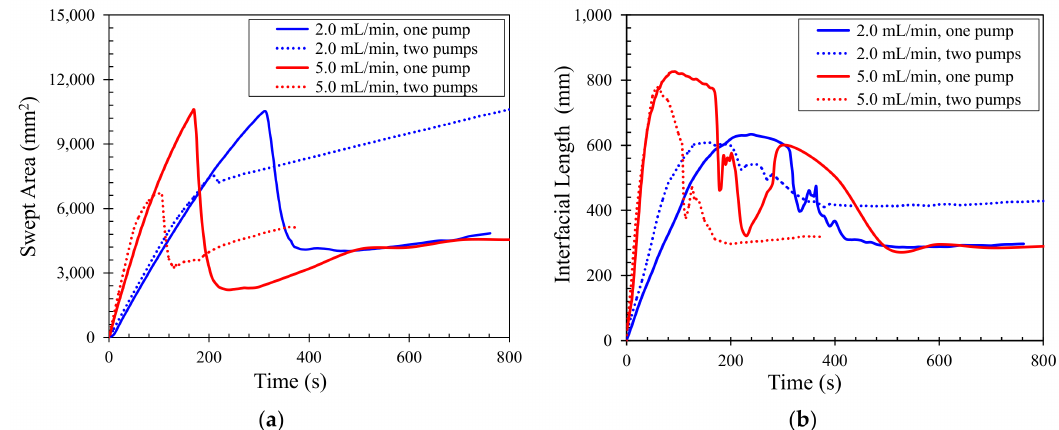
Figure 11. Comparison of constant pressure control at the outlet (one pump) and constant production rate at the outlet (two pumps) scenarios at two different water injection rates. ( a ) Swept area vs. time; ( b ) Interfacial length vs. time.